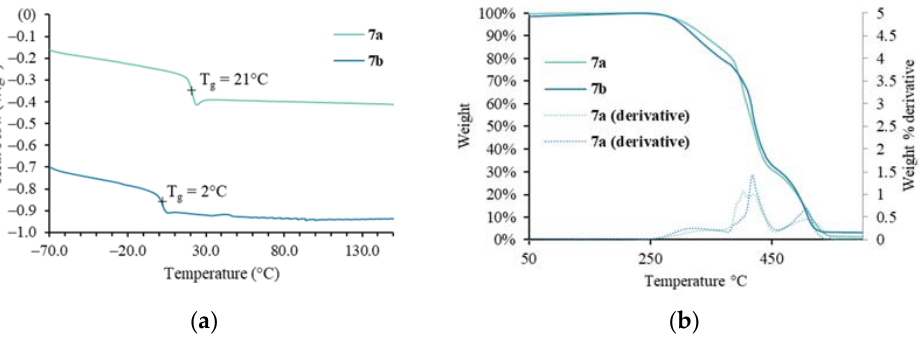
Figure 6. Thermal analysis of 7a and 7b : ( a ) DSC measurement, heating rate 10 °C/min, data have been o ff set one from another by − 0.5 W.g − 1 ; ( b ) TGA measurement, under air at a heating rate of 10 offset one from another by − 0.5 W · g − 1 ; ( b ) TGA measurement, under air at a heating rate of 10 ◦ °C/min.